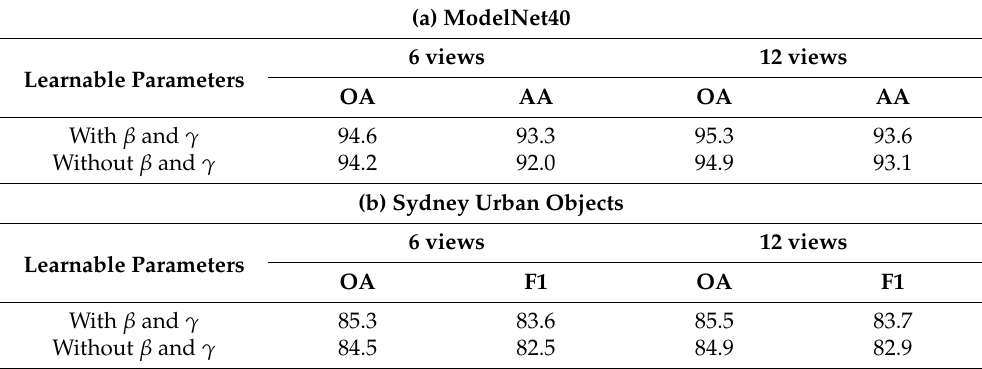
Table 6. Comparison of classification performance with or without the learnable parameters β and γ